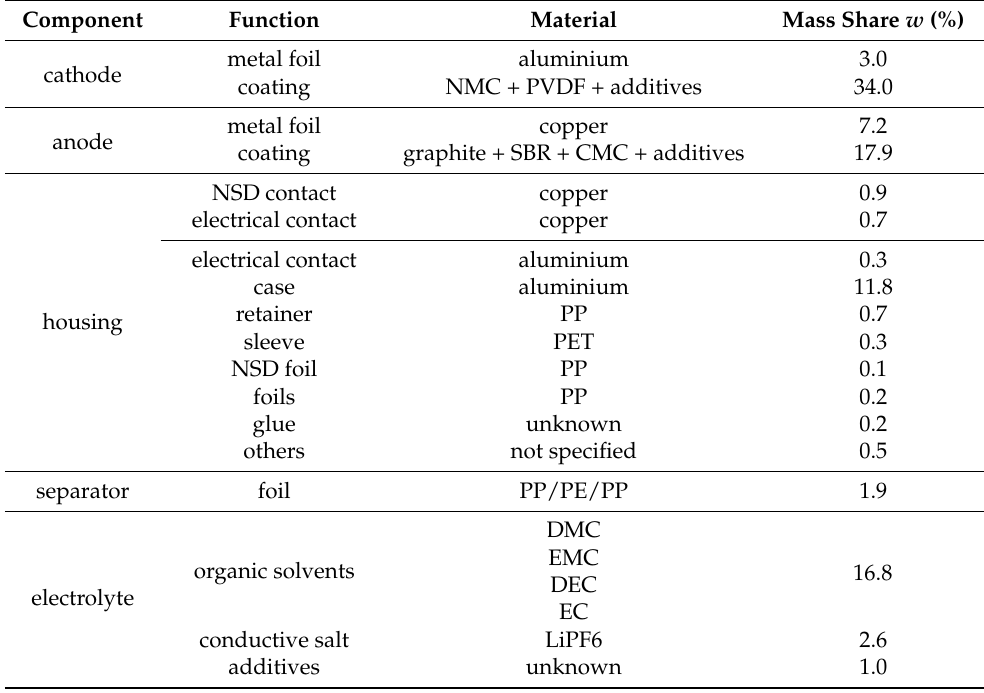
Table 1. Cell composition of the test material, reprinted with permission from